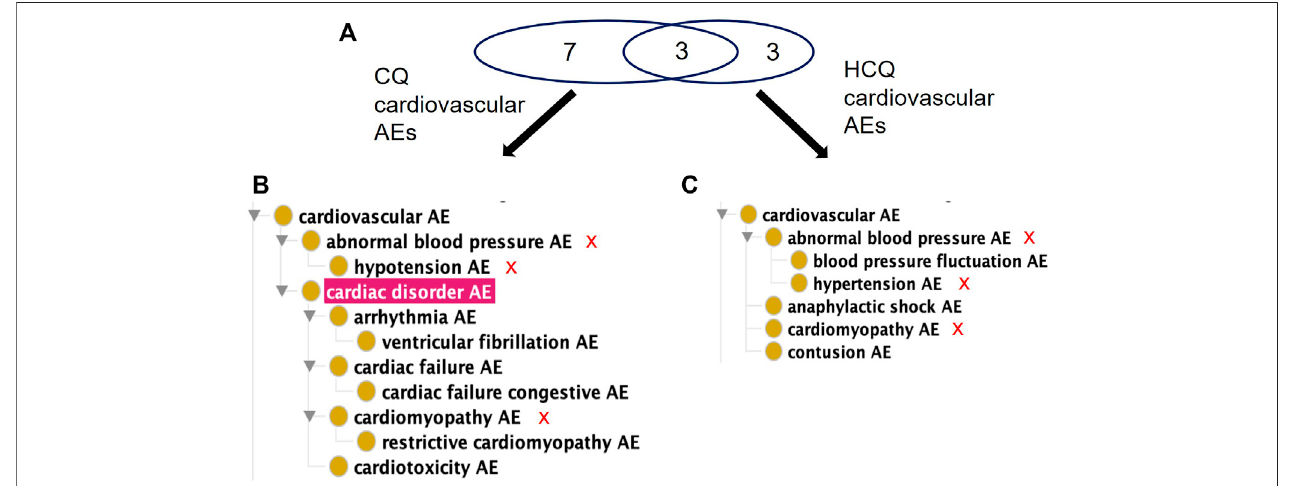
FIGURE 3 | Comparison of signi fi cant cardiovascular AEs for CQ and HCQ from the FAERS database. (A) Venn Diagram of signi fi cant cardiovascular AEs for CQ andHCQ. (B) OAEclassi fi cationof10signi fi cantcardiovascularAEsforCQ.(C)OAEclassi fi cationof6signi fi cantcardiovascularAEsforHCQ.Theredsignof “ X ” nextto the AEterms in (B,C) represent the shared AEfor CQ and HCQ. Note that cardiac disorder AE passed the signi fi cance threshold for CQ (A) but not for HCQ (B) . Overall CQ was associated with more cardiovascular AEs.